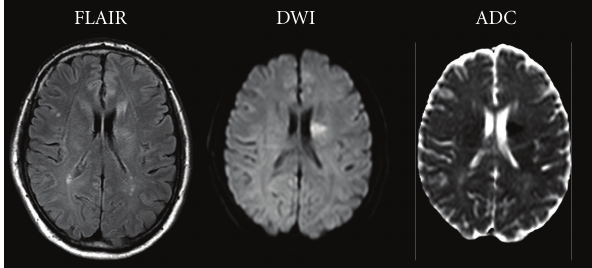
Figure 8: Case 3: Follow-up MRI with FLAIR, DWI and ADC showing a small lacunar infarction in the right corona radiata that is also seen retrospectively on the CTP maps (Figure